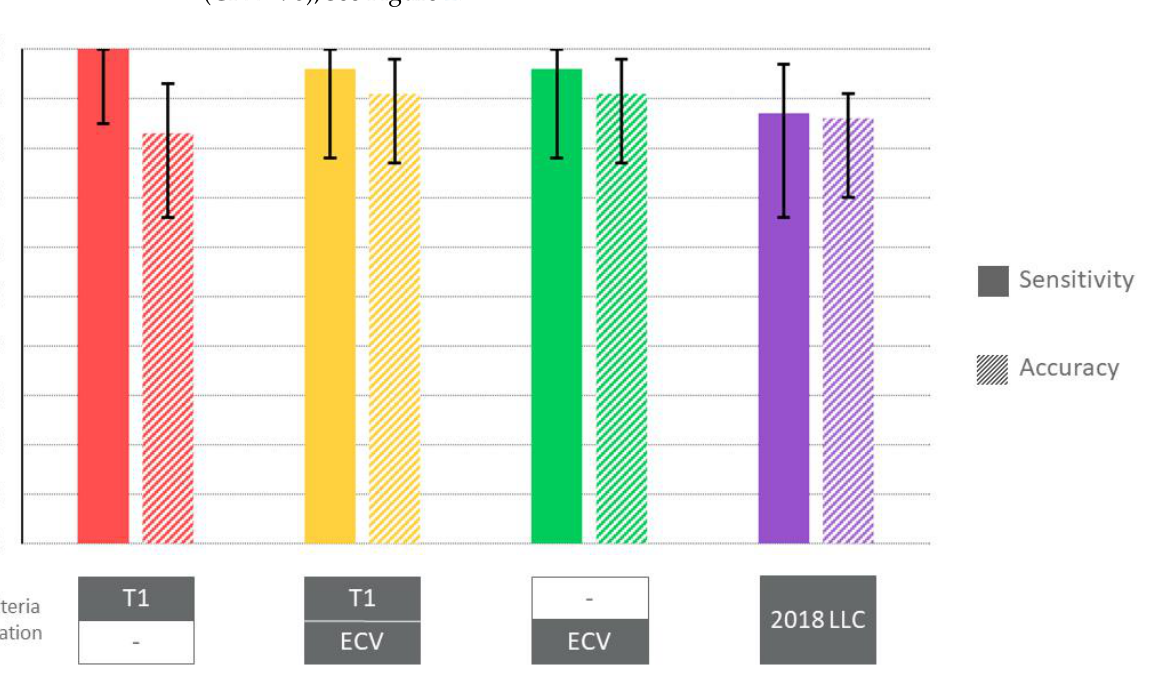
Figure 1. CMR Parameter ROC Curves for Discrimination of Subacute Myocarditis from Healthy Controls and Acute Myocarditis. ( A ) ROC curves demonstrate excellent areas under the curve (AUCs) for all four tissue characterization parameters for discrimination of acute myocarditis from healthy controls. ( B ) In the discrimination of subacute myocarditis from healthy controls, LGE and ECV performed best with AUCs of 0.96 ( p < 0.0001) and 0.90 ( p < 0.0001) respectively; 0.79 ( p < 0.001) for T 2 with a criterion of >49 ms; 0.76 ( p = 0.002) for T 1 with a criterion of >1015 ms. ( C ) For compar- ison of acute from subacute myocarditis, the areas under the curve (AUCs) were 0.76 ( p < 0.001) for LGE with a criterion of >2, 8% of LV myocardial mass; 0.66 ( p = 0.049) for T 2 with a criterion of >51 ms; T 1 and ECV showed no significant differences. The diagonal line course indicates difficult dis- crimination of acute vs. subacute myocarditis by CMR alone.